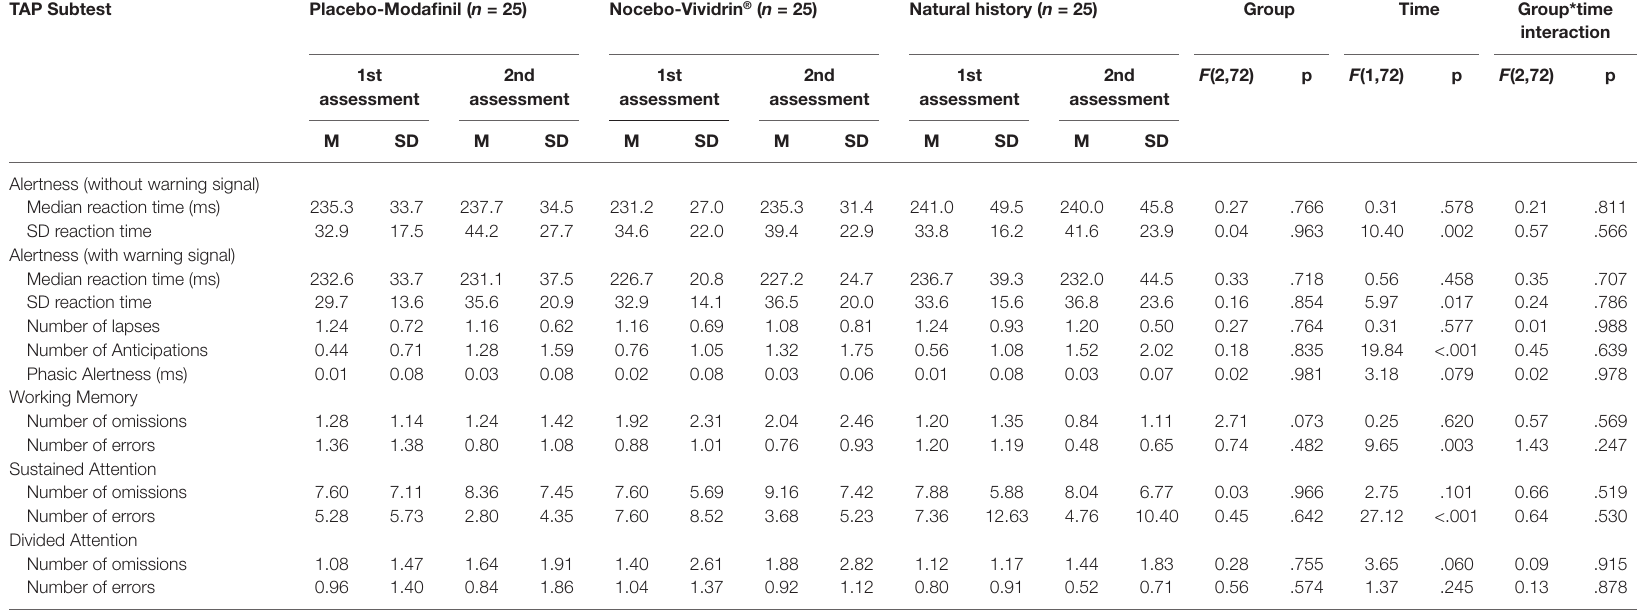
TABLE 2 | Cognitive performance (TAP scores at 1 st assessment and 2 nd assessment) per group and group*time interaction. TAP Subtest Placebo-Modafinil ( n = 25) Nocebo-Vividrin ® ( n = 25) Natural history ( n = 25)